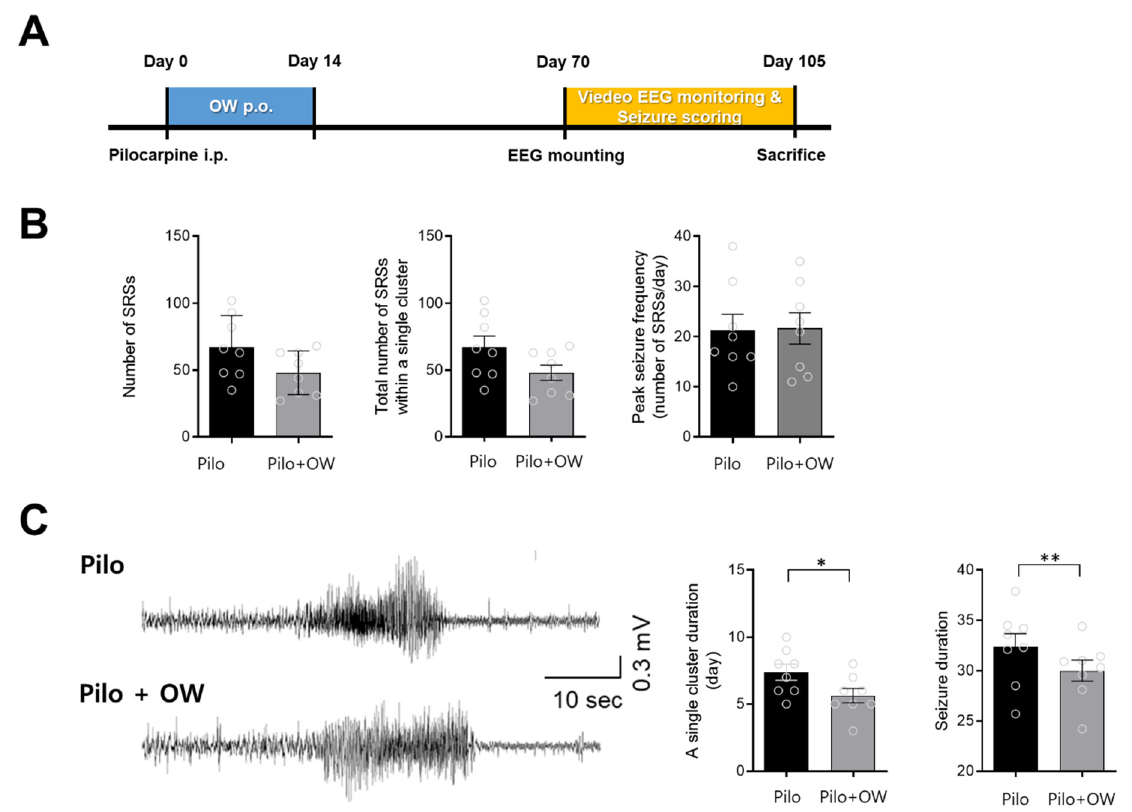
Figure 4. Effect of OW in pilocarpine (Pilo) mouse model. ( A ) The experiment was performed after administration of pilocarpine injection and OW for 1 week. ( B ) OW did not significantly decrease the number of spontaneous recurrent seizures (SRS), total number of SRSs within a single cluster, or peak seizure frequency. ( C ) Representative electroencephalogram (EEG) traces of SRS show that OW significantly reduced the number of days with clustered SRS and duration of a single SRS. Error bars denote SEM (Mann–Whitney test: * p < 0.05, ** p < 0.01).